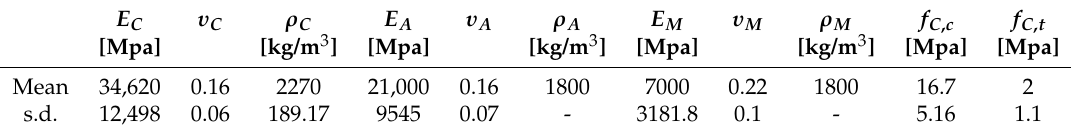
Table 2. Material test